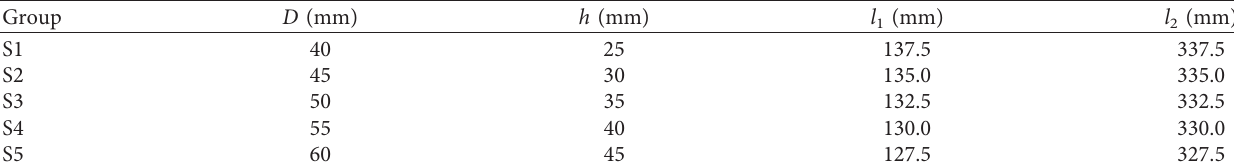
Table 2: The parameters of the model